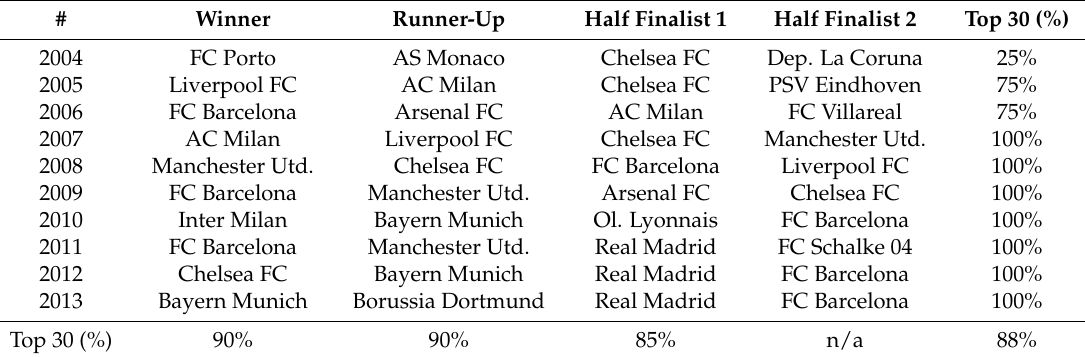
Table 3. Top four teams in UEFA Champions League